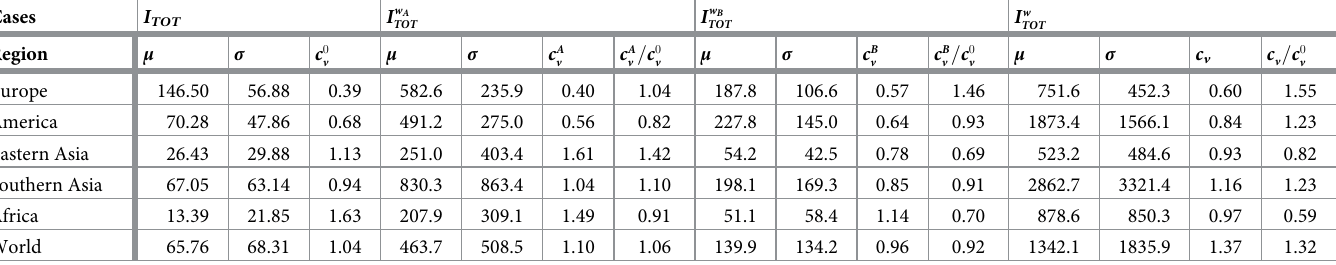
Table 1. Statistics of I TOT the total number of COVID-19 cases per thousand inhabitants on 10 January 2022 since the beginning of the pandemic. Four variables are considered: the unweighted number, the numbers weighted by the proportion of aged people ( w A ), by the number of hospital beds per inhabitant ( w B ) or both ( w ). The coefficient of variation c = σ / μ is calculated for each variable (with σ the standard deviation and μ the mean). The variation coefficients of the weighted numbers are then v compared to the unweighted ones. Statistics are provided for five ensembles (Europe, America, Eastern and Southern Asia and Africa), and for the whole world. Cases